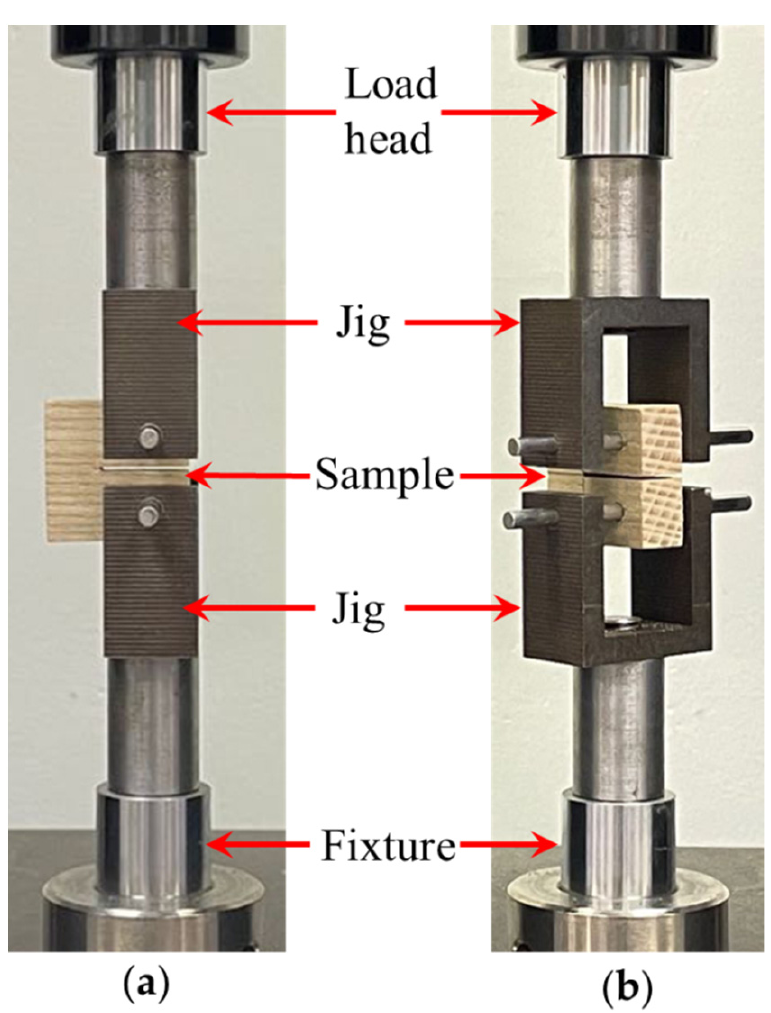
Figure 3. Setup for measuring fracture characteristics using compact tension test ( a ) front view, and ( b ) perspective view.